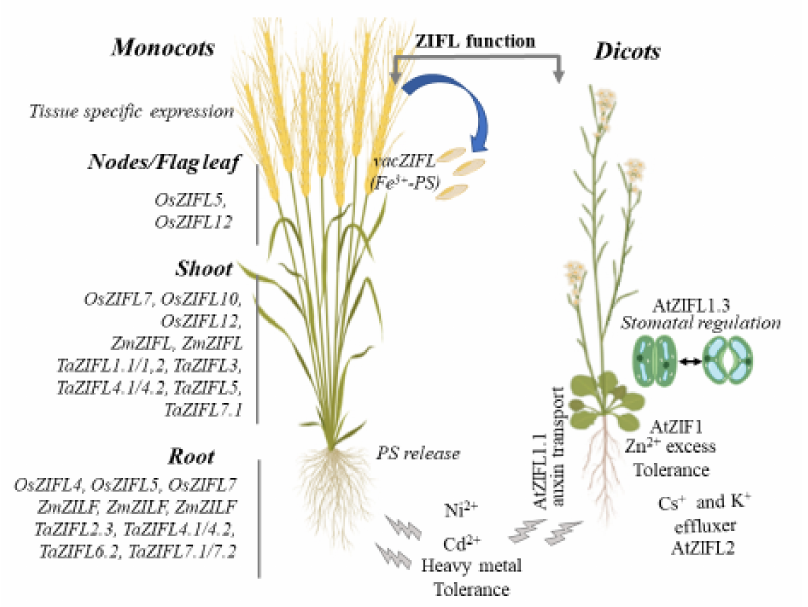
Figure 4. Overview of the plant ZIFL transporters characterized for their known functions. The list on the left side of the picture describes the tissue-specific expression response of the multiple ZIFL genes from crop plants, such as rice and wheat. On the right side of the image, ZIFL transporter functions are elaborated in the dicot, such as Arabidopsis . ZIFL’s function to provide tolerance to Ni and Cd stress seems to be conserved among the monocots and dicots. Table 1. List of ZIFL homologs form the selected plant species. The table enlists a number of genes that have been identified and characterized for the function in the mentioned plant species